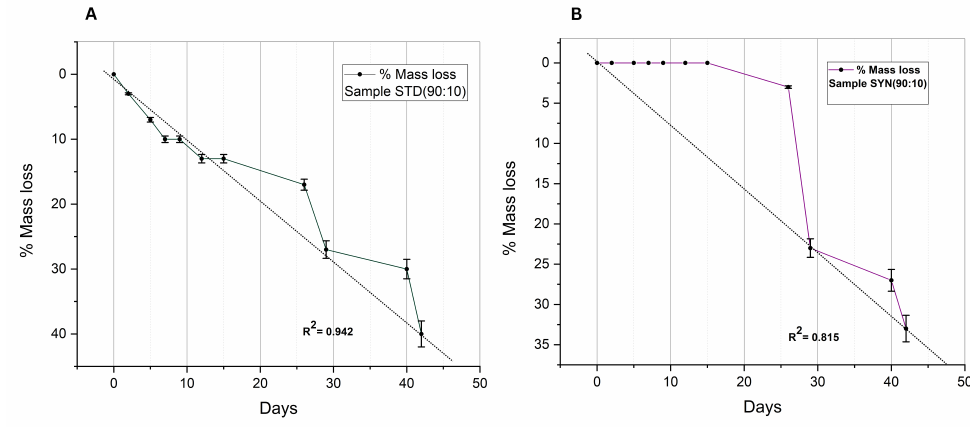
Figure 9. Degradation curves of samples: ( A ) STD (90:10); ( B ) SYN (90:10).